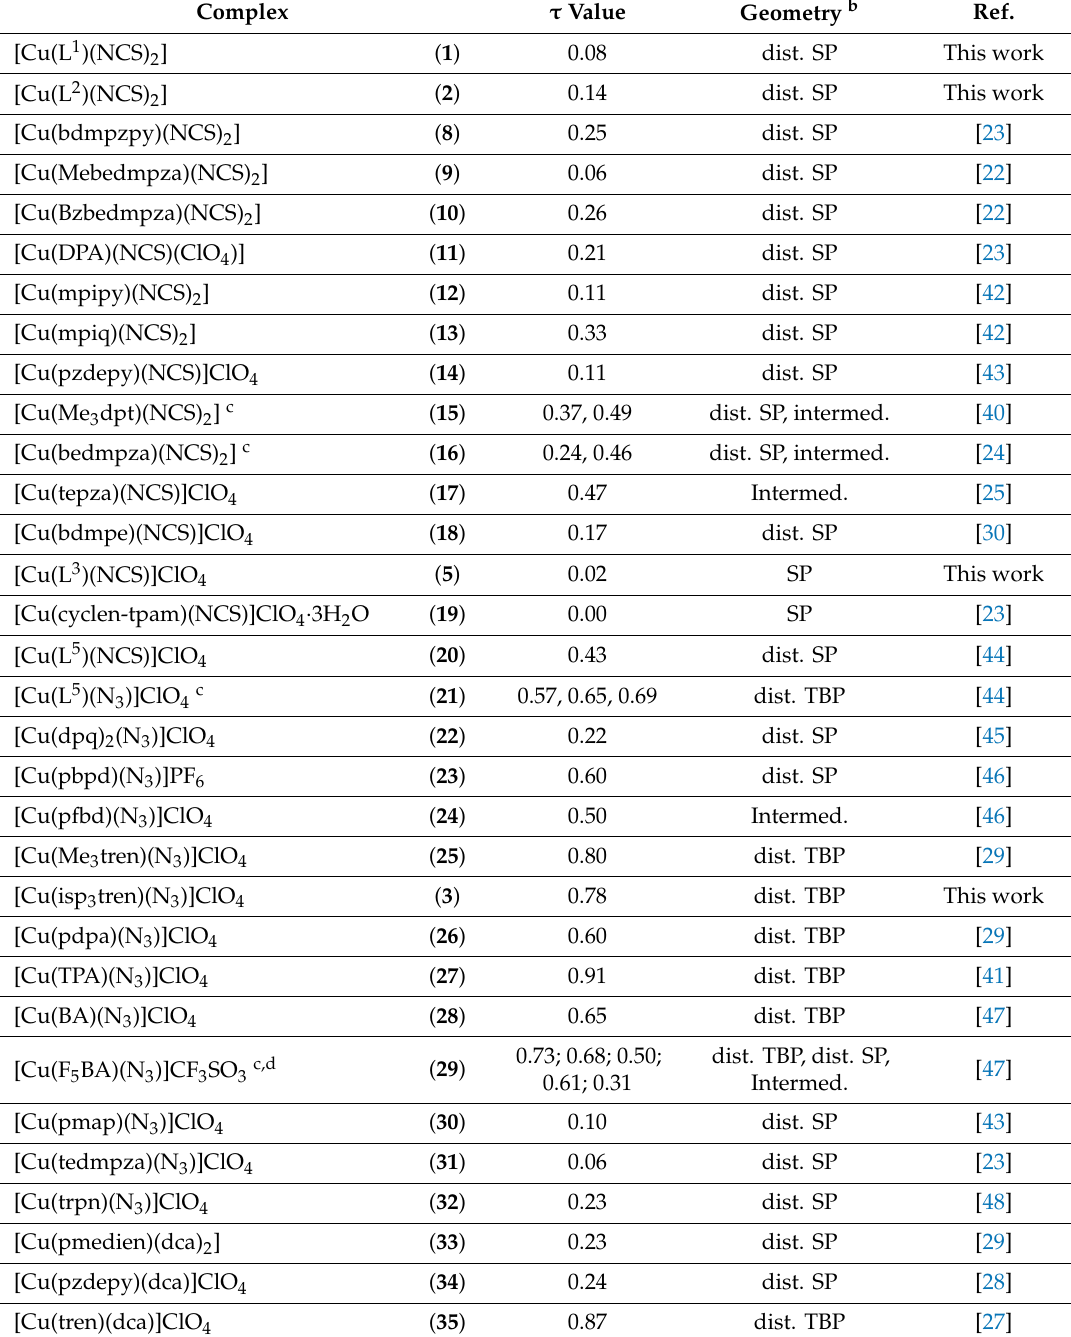
Table 1 together with their corresponding τ values. Furthermore, the visible spectra of the same series of compounds in solutions are collected in Table 2. Comparing the molecular and solution structures should provide some information about the validity of the predicted geometry in solutions and to what extent one can rely on the structural results in solutions. Table 1. Geometry and distortion parameter ( τ ) in mononuclear five-coordinated pseudohalido-copper(II) complexes derived from N -donor ligands in the solid states a